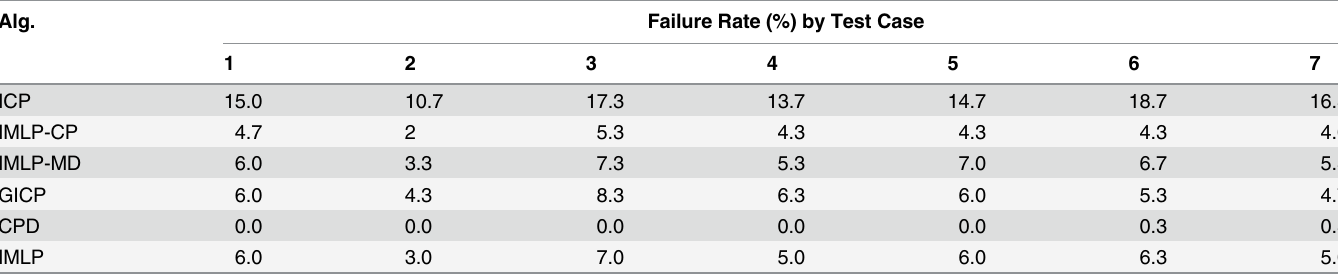
Table 12. Registration failure rates for sub-shape registration. (Experiment 6). Alg. Failure Rate (%) by Test Case